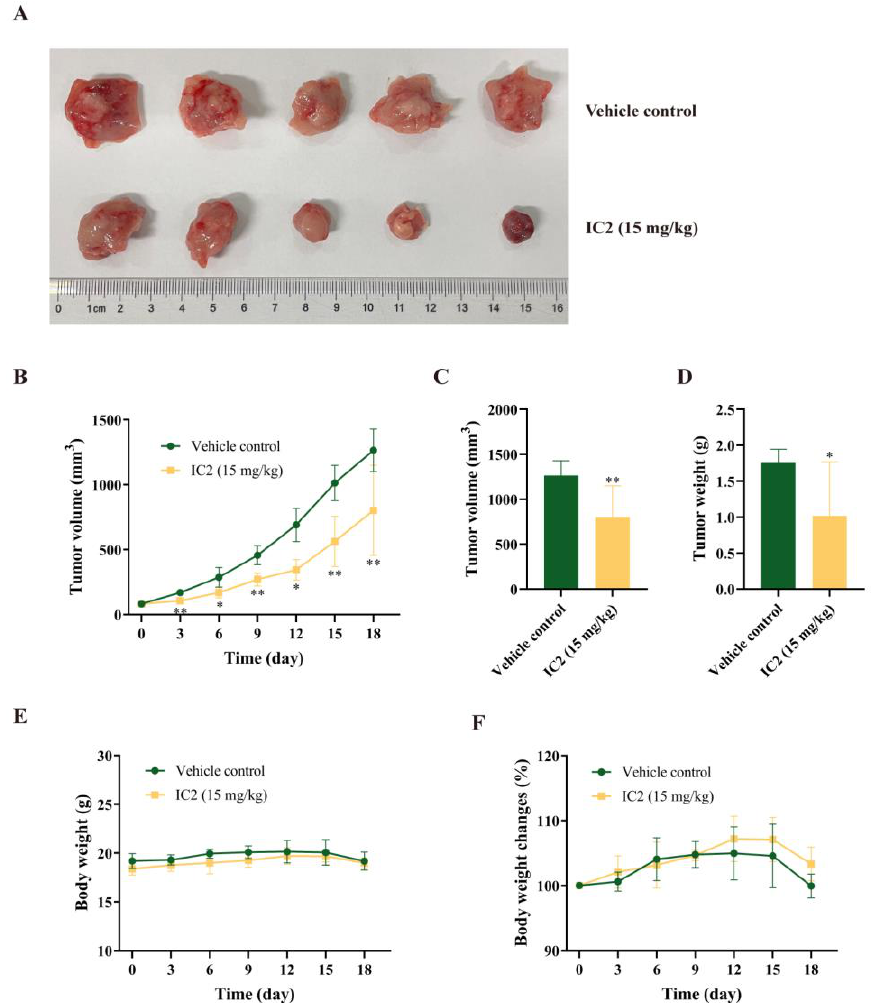
Figure 6. Antitumor activity of IC2 in 4T1 mouse xenograft model. ( A ) Representative photograph of removed tumor from the sacrificed mice at the end of the experiment. ( B ) Tumor volume (mm 3 ) measured at indicated time points throughout treatment with IC2 (15 mg/kg). ( C ) Tumor volume (mm 3 ) and ( D ) tumor weight at day 18 in groups treated with IC2 (15 mg/kg). ( E , F ) Body weight measured at indicated time points throughout treatment with IC2 (15 mg/kg). * p < 0.05, ** p < 0.01 and *** p < 0.001 compared with the control group.